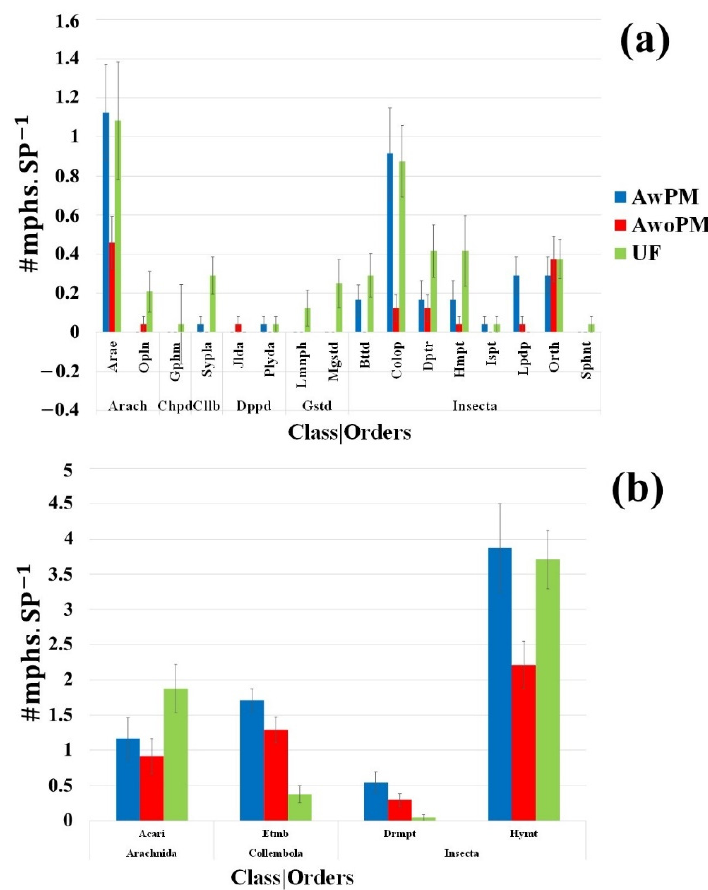
Figure 8. Composition of above-ground dwellers. Mean number of morphospecies per sampling point (#mphs.SP − 1 ) of ( a ) least dominant and ( b ) most dominant orders. Arach= Arachnida, Arae = Araneae, Bttd = Blattodea, Chpd = Chilopoda, Cllb = Colembolla, Colop = Coleoptera, Dppd = Dip- lopoda, Dptr = Dermaptera, Etmb = Entomobryomorpha, Gphm = Geophilomorpha, Gstd = Gastropoda, Hmpt = Hemiptera, Istp = Isoptera, Jlda = Julida, Lmnph = Limnophila, Lpdp = Lepidoptera, Mgstd = Mesogastropoda, Opln = Opil- iones, Orth = Orthoptera, Plyda = Polydesmida, Sphnt = Siphonaptera, Sypla = Symphypleona. AwPM = agriculture with plastic mulch and GLY; AwoPM = agriculture without plastic mulch and the use of GLY; UF = unmanaged farming system: SP = sampling